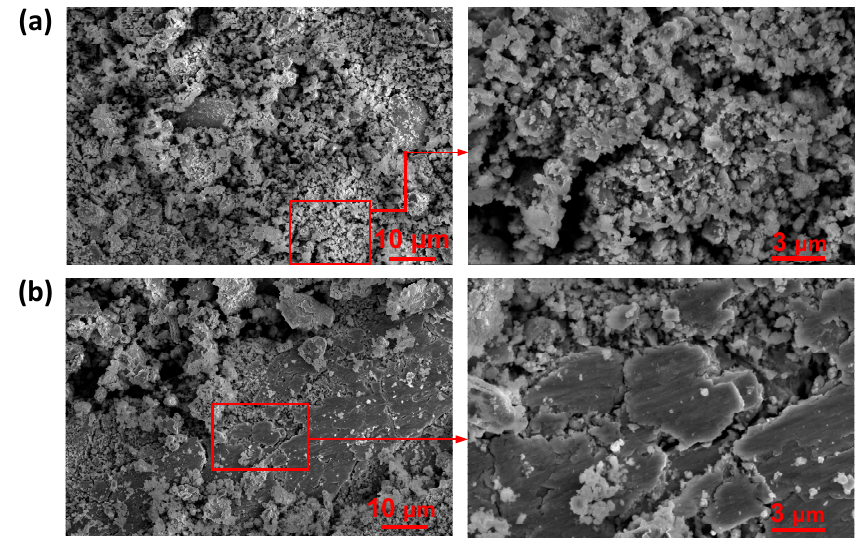
Figure 7. SEM morphologies of wear debris: ( a ) fretting; ( b ) sliding.